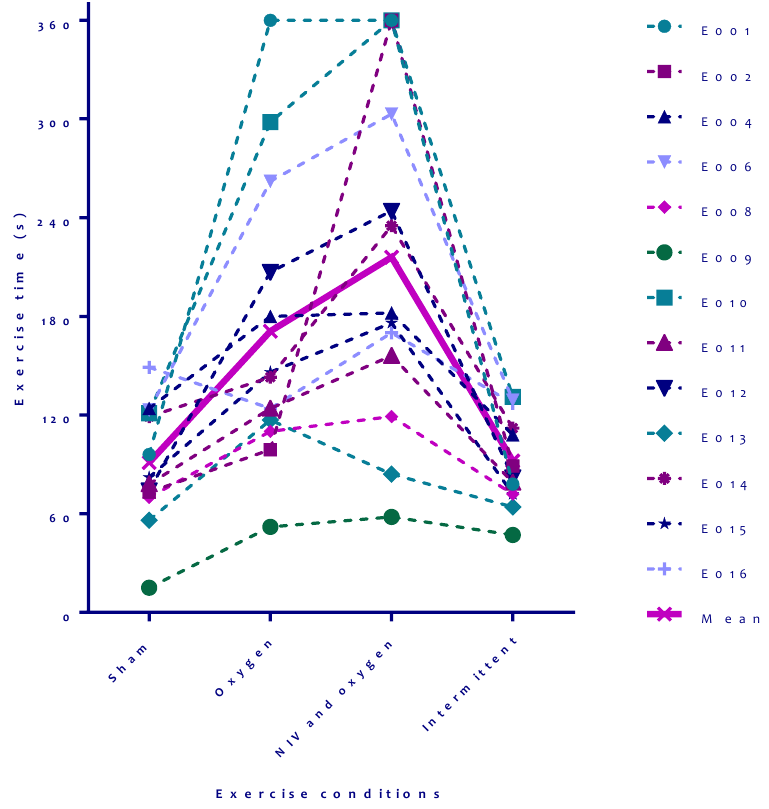
Figure 4. Individual results with different settings on the first bout of exercise. Abbreviations: s = seconds, NIV = non-invasive ventilation.